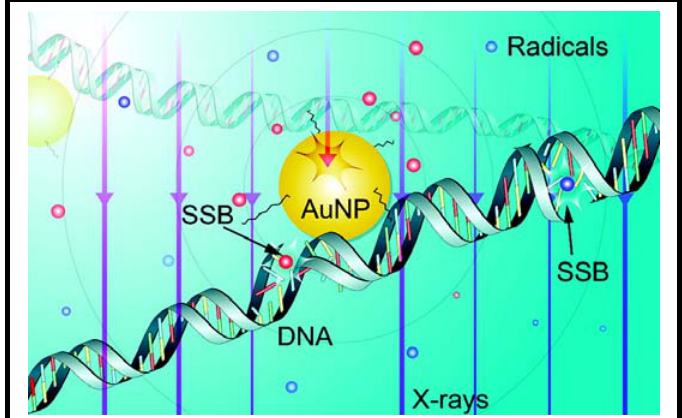
Figure 3. Mechanisms of radiation induced DNA damage in the presence of the GNPs: Schematic diagram of the results of a Monte Carlo simulation. Also shown are the radicals (blue spheres, distributed evenly) generated from electrons produced in water, as well as radicals (red spheres, concentrated near the GNP) from Auger electrons, secondary and photoelectrons originated from the GNP. The trajectories of electrons are not shown, and only the relative average density of radicals generated from these electrons is displayed. The diameter of the GNP shown here is approximately 3 nm. Reproduced with permission